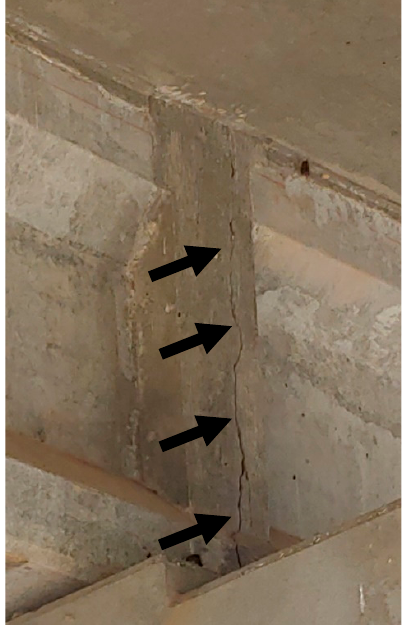
Figure 1. Example of continuity joint damage noted by arrows.